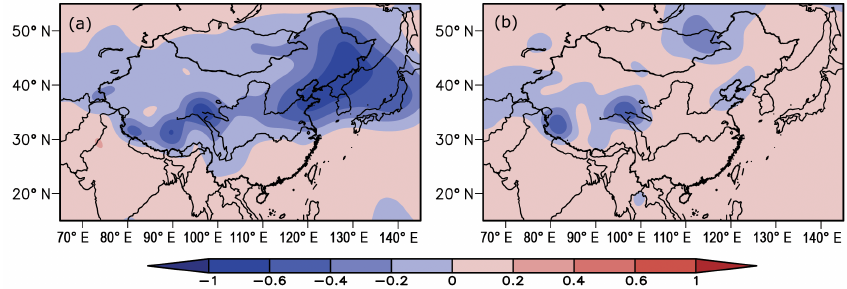
Figure 10. Simulated difference in summer surface air temperature between CON and SEN in (a) heavy and (b) light dust